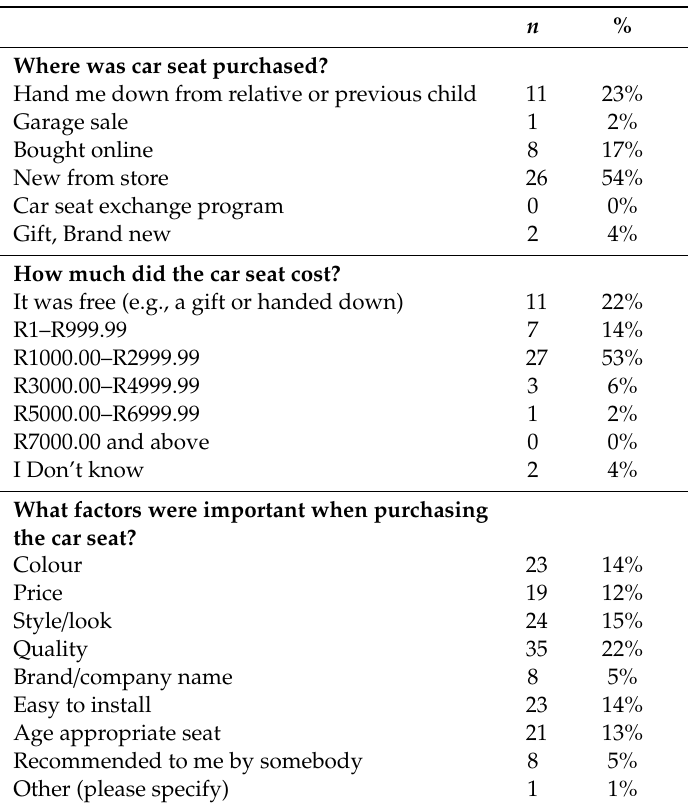
Table 5. Factors associated with purchase of child